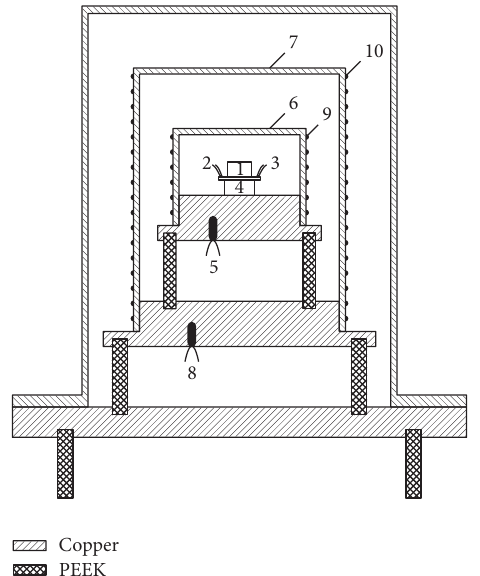
Figure 2: Schematic diagram of the Peltier-element-based adiabatic scanning calorimeter. The sample cell 1 is in good thermal contact with the miniature heater 2 and temperature sensor 3 on top of the Peltier element 4 positioned on the bottom part of the first adiabatic shield 6, itself surrounded by another thermal shield 7. 9 and 10 are resistive heaters and 5 and 8 resistance thermometers. The whole calorimeter is placed in a temperature controlled